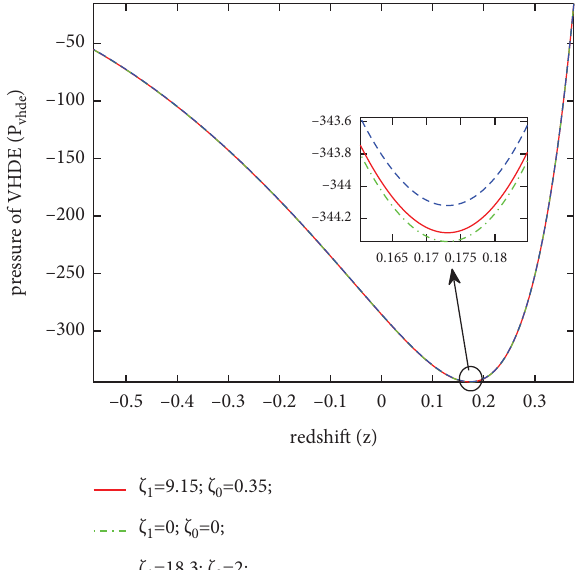
Figure 3: Te pressure of VHDE( P